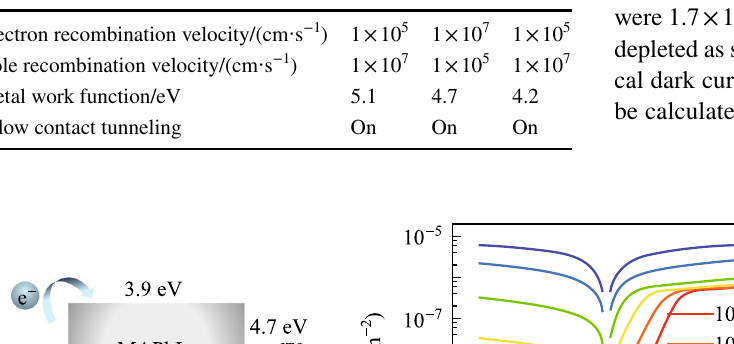
Table 3 Material parameters of the contact electrodes Parameters